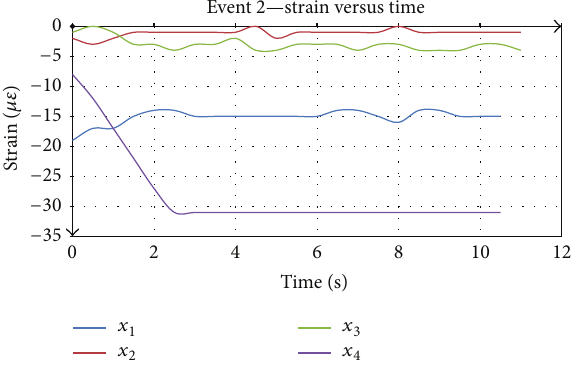
Figure 39: Total increase in strain in direction 𝑥 .